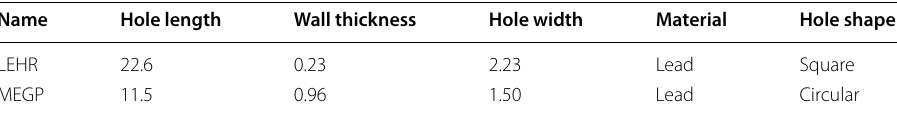
Table 1 Collimator dimensions